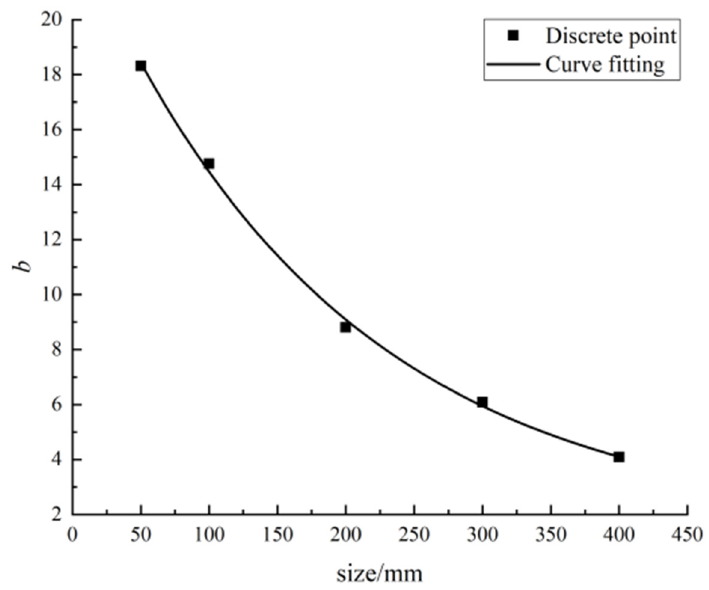
Figure 7. Fitting curve of parameter b and size.